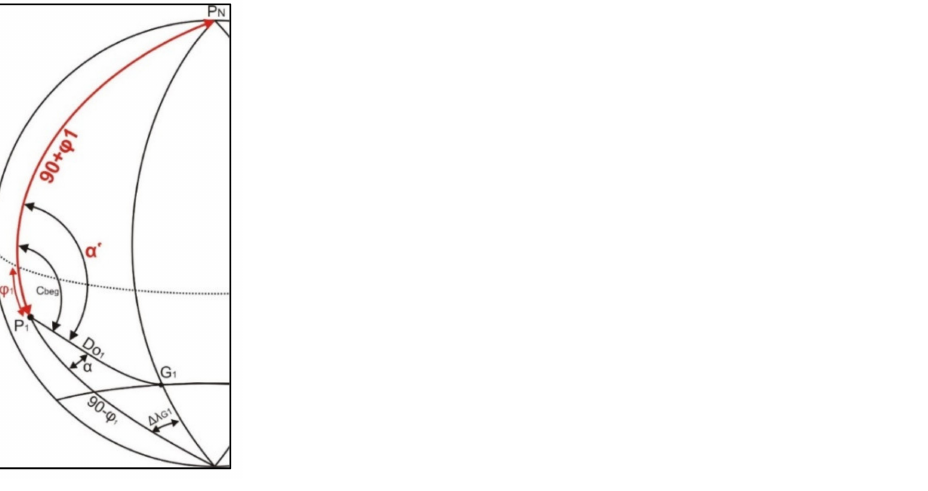
Figure 6. Mistake in the interpretation of angle α / β due to the latitude sign.